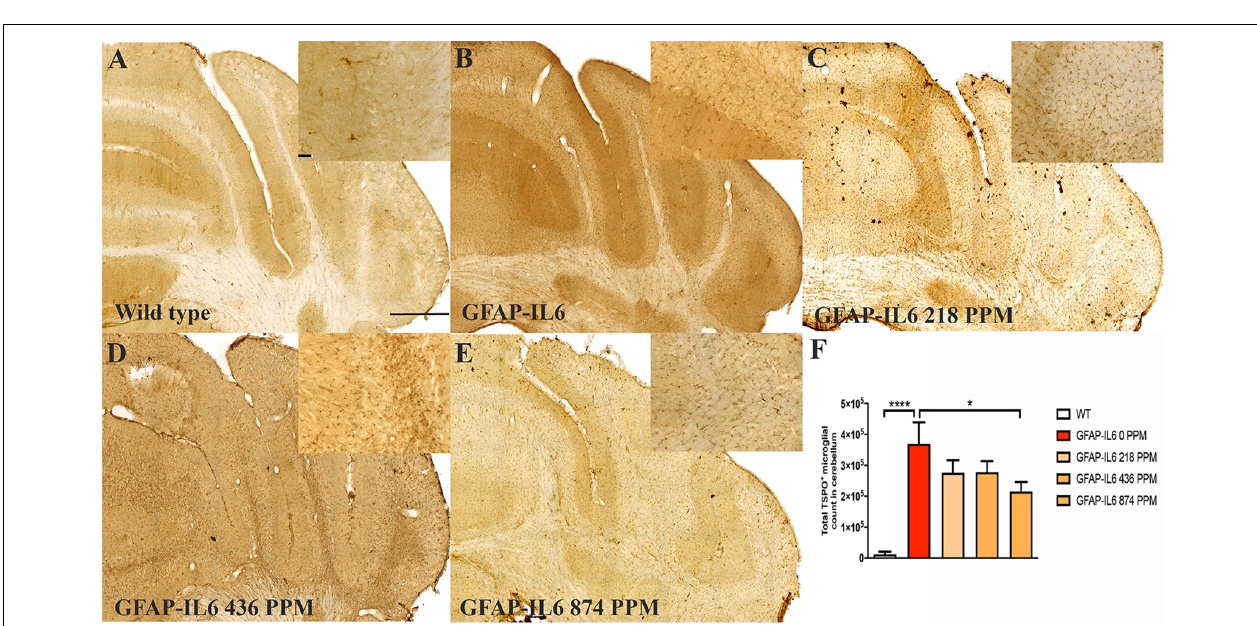
FIGURE 3 | MC decreased the number of TSPO + microglial cells/macrophages in the hippocampus of GFAP-IL6 mice. (A–E) Representative photomicrographs of immunohistochemistry staining for the microglia (TSPO + cells) of the hippocampus. (Magnification 10x objective field, scale bar = 500 µ m and 100 µ m in inserts). Images are representative of at least six animals per group ( n = 6). (F) Graphical representation of total TSPO + microglial/macrophages count in the hippocampus. The graph represents the mean ± SEM and significant differences were determined using one-way analysis of variance (ANOVA). Significance = * p < 0.01, **** p < 0.0001.